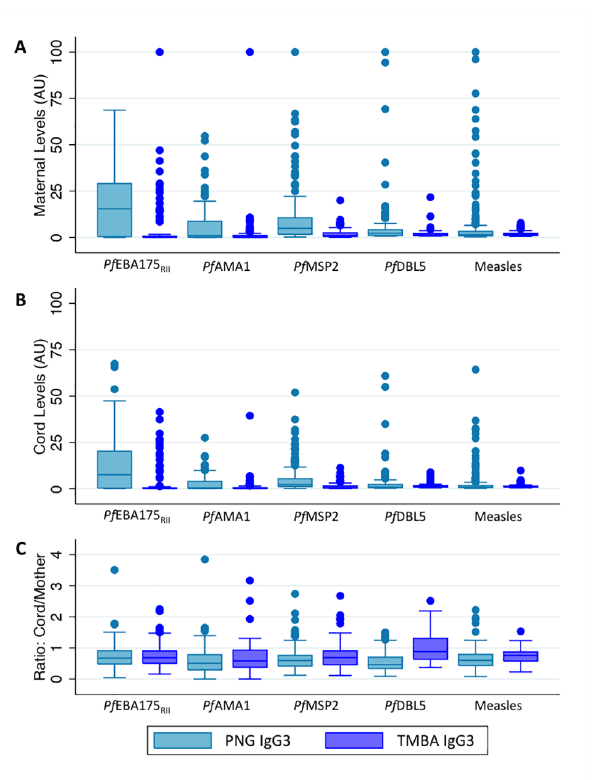
Fig 2. Maternal and cord IgG3 levels by study site. (A) Maternal IgG3 levels (arbitrary units) by study site. (B) Cord IgG3 levels (arbitrary units) by study site. (C) Cord:maternal IgG3 ratio by study site.